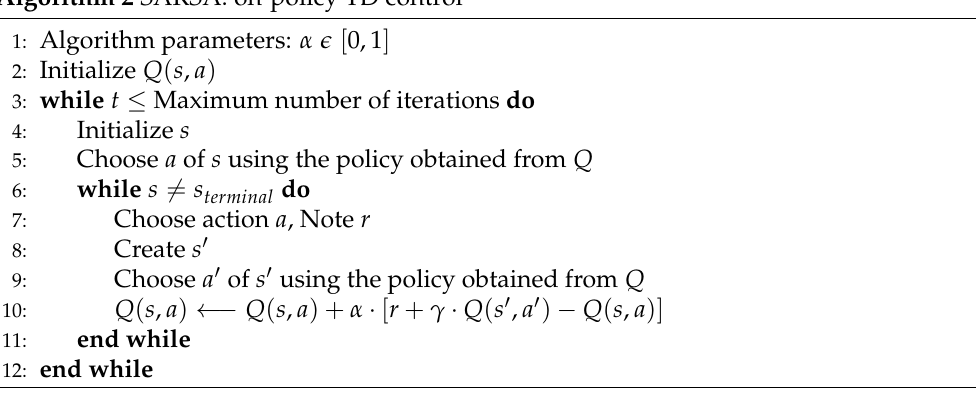
Algorithm 2 SARSA: on-policy TD